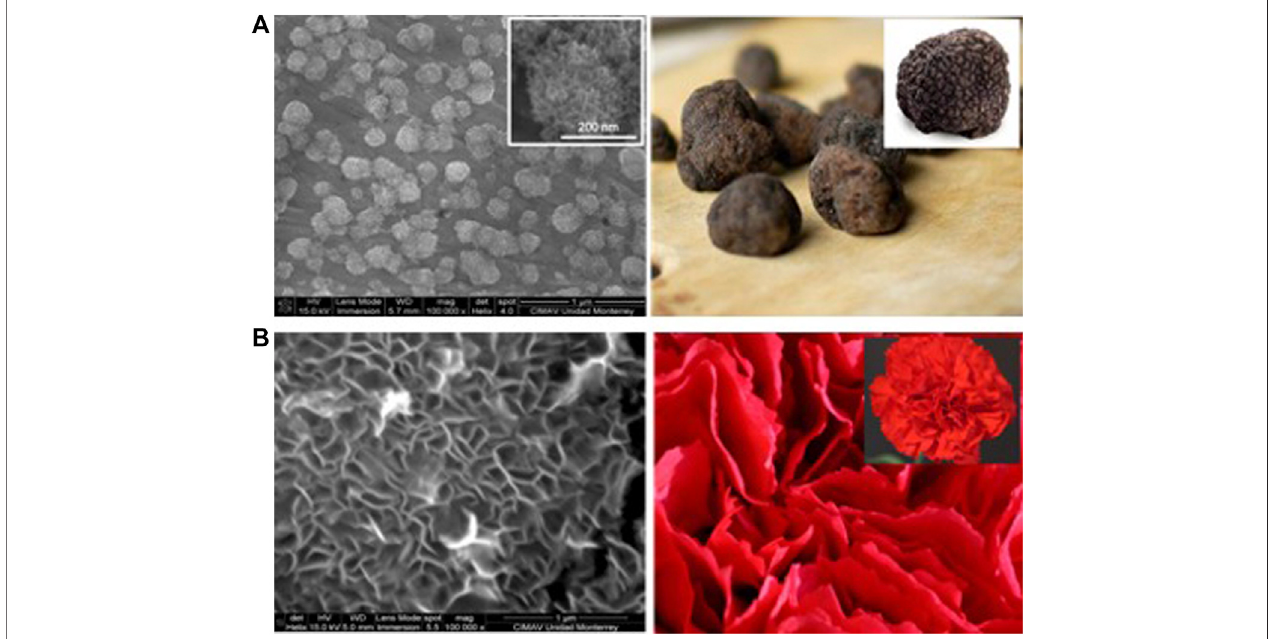
FIGURE 12 | (A) SEM image of electrodeposited Pt hierarchical superstructures onto a glassy carbon electrode using an LSV approach. This image corresponds to an unpublishedimagefromtheauthors.Theobtainedstructuresresemblethetruf fl es (Tubermelanosporum) structuresasshowninthephotographsontheright. “ BlackTruf fl es ” by ulteriorepicureislicensedunderCCBY-NC-ND2.0.Availableon:https://www. fl ickr.com/photos/13329406@N00/370974435. (B) SEMimageoftheNiCoalloydepositedonto anAuelectrode,unpublishedresultsfromtheauthors.ThewrinkledstructureoftheNiCosheetsresemblesthedistributionofthepetalsincarnation (Dianthuscaryophyllus) fl owers. “ Red carnation for mother ” by koizumi is licensed under CC BY-NC-ND 2.0. Available on: https://www. fl ickr.com/photos/59959574@N00/497080969